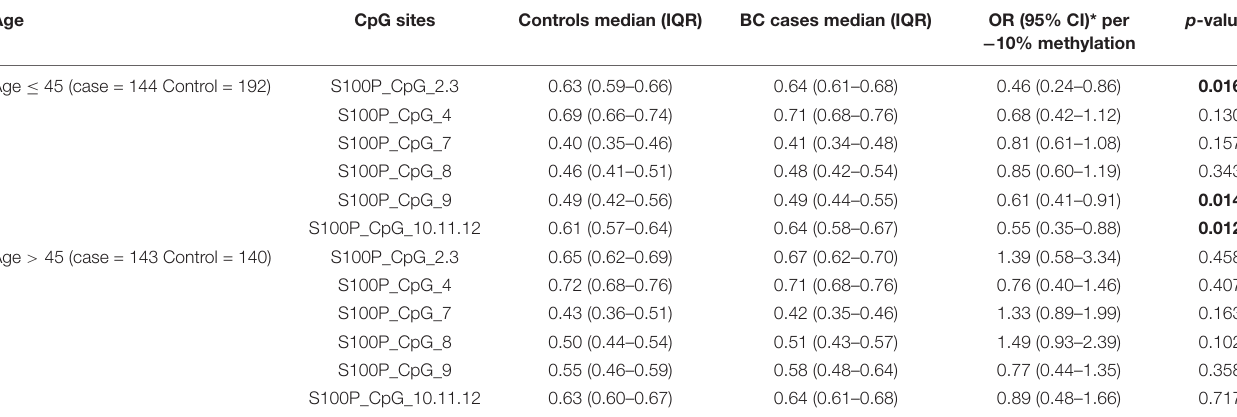
TABLE 2 | Methylation differences of S100P between BC cases and controls in Study I stratify by median of